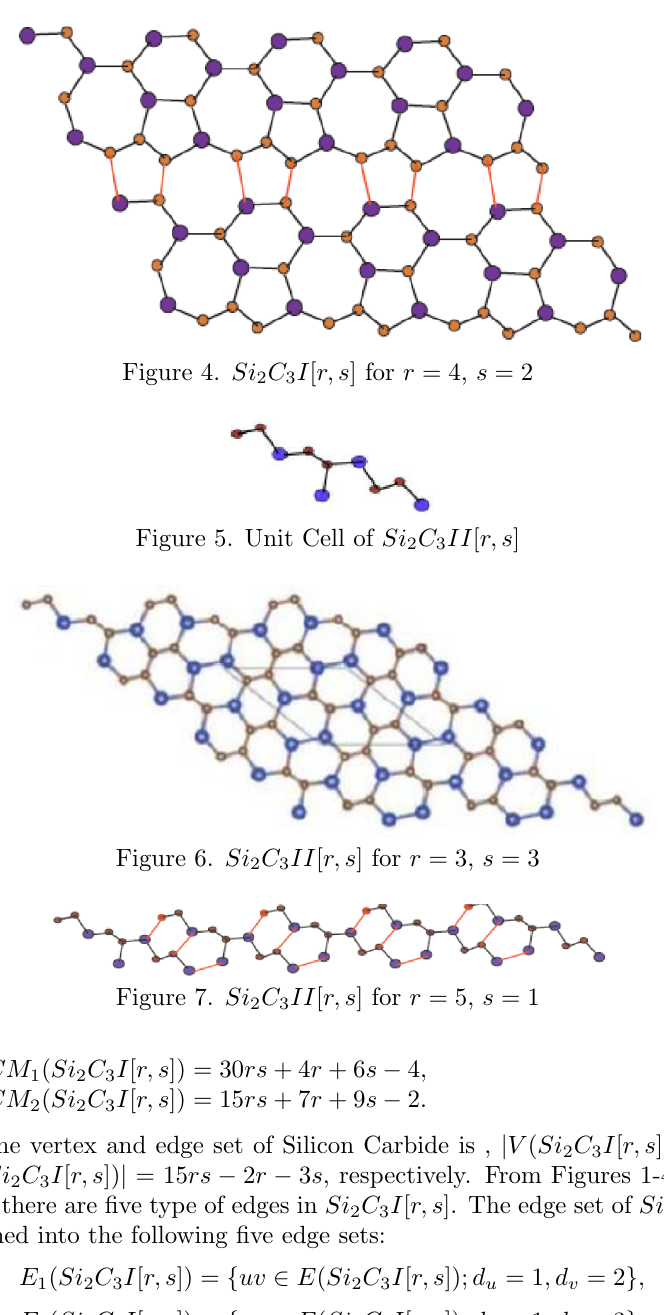
Figure 7. Si 2 C 3 II [ r, s ] for r = 5, s =